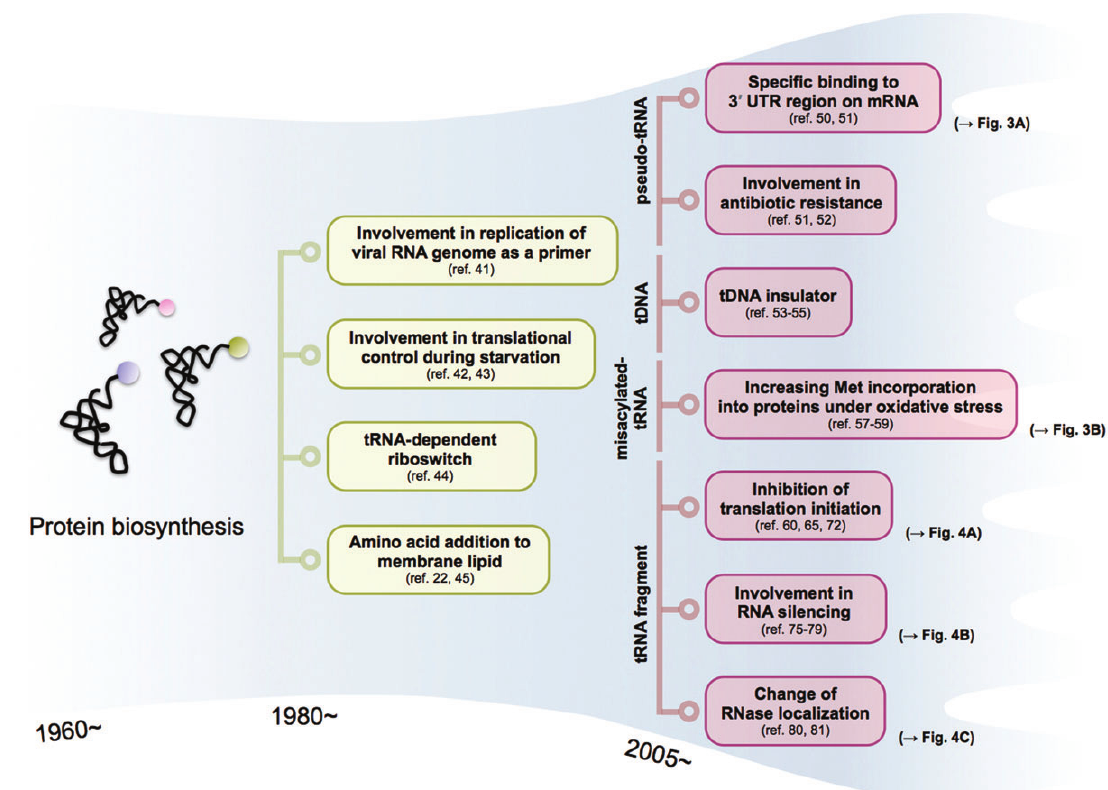
Figure 2 Expansion of known tRNA functions during the past 50